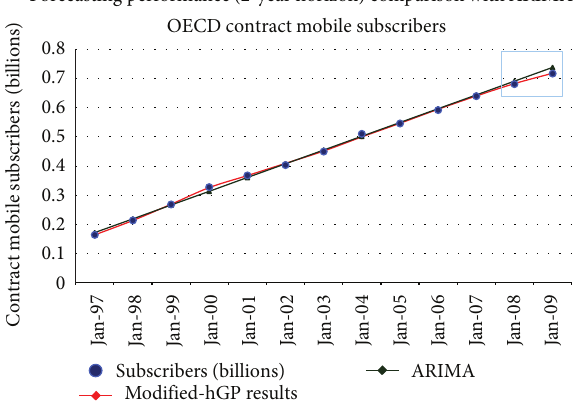
Figure 32: Comparison of the forecasting performances of modified-hGP with ARIMA model (forecast window—2 years ahead) for the number of OECD mobile contract subscribers.